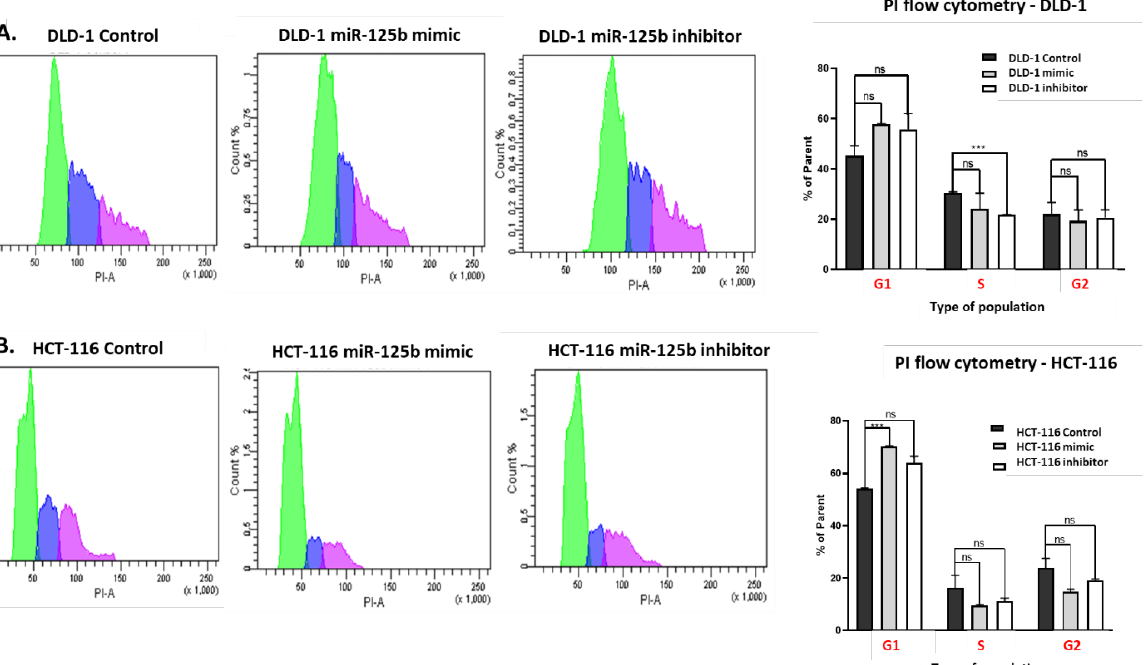
Figure 4. miR-125b modulation effects on cell cycle progression. ( A , B ) Flow cytometry analysis for detection of cell cycle progression for ( A ) DLD-1 and ( B ) HCT-116 treated with miR-125b mimic (100 nM) or inhibitor (100 nM) compared to control. Experiments were performed in biological triplicates for each cell line and each treatment scheme (data presented as mean ± S.D., *** p = 0.000542 for DLD-1 <phase S> treated with 125b inhibitor independent t -test compared to DLD-1 control; *** p = 0.000240 for HCT-116 <phase G1> treated with 125b mimic independent t -test compared to HCT-116 control). The colors present in the flow cytometry graphs for cell cycle analysis are representative for each phase of the cell cycle: green—G1 phase, blue—S phase, pink—G2 phase.